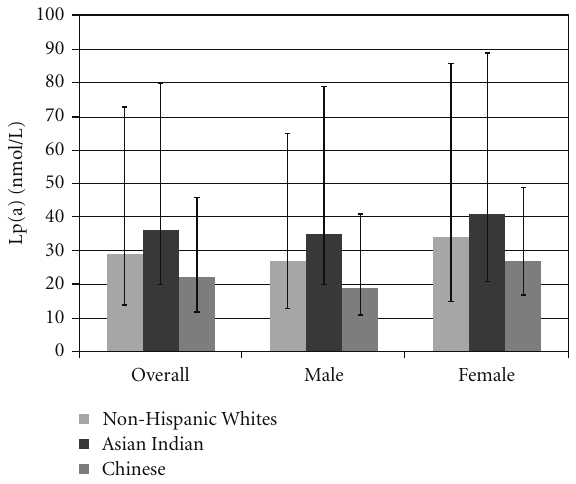
Figure 1: Median Lipoprotein (a) concentration by racial/ethnic group and interquartile range (25th–75th